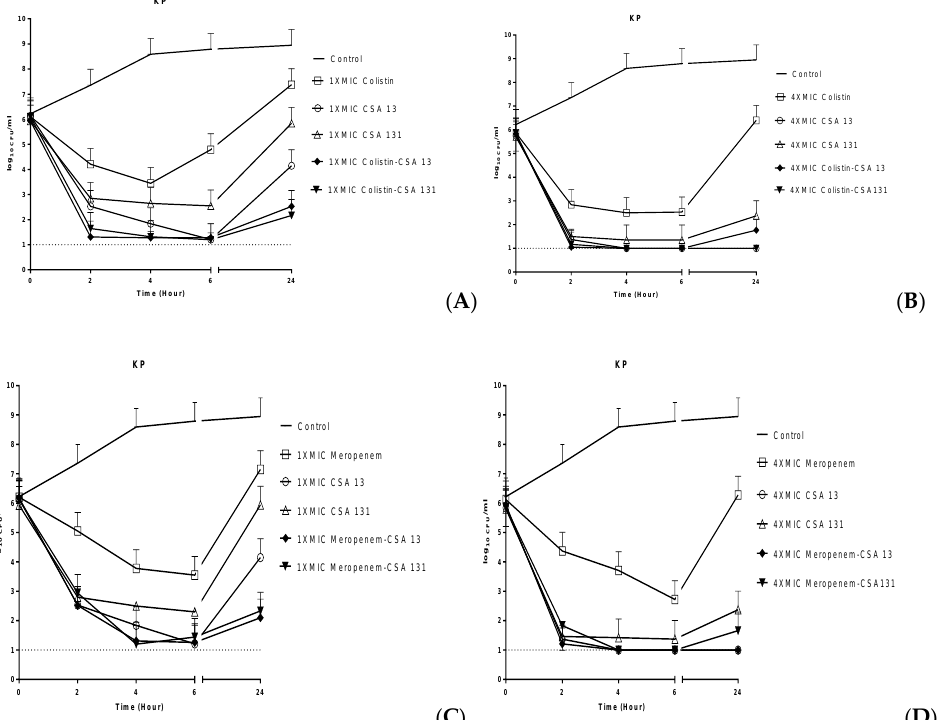
Figure 2. The mean results of killing activity of two CSAs with colistin or meropenem combinations against six K. pneumoniae strains.